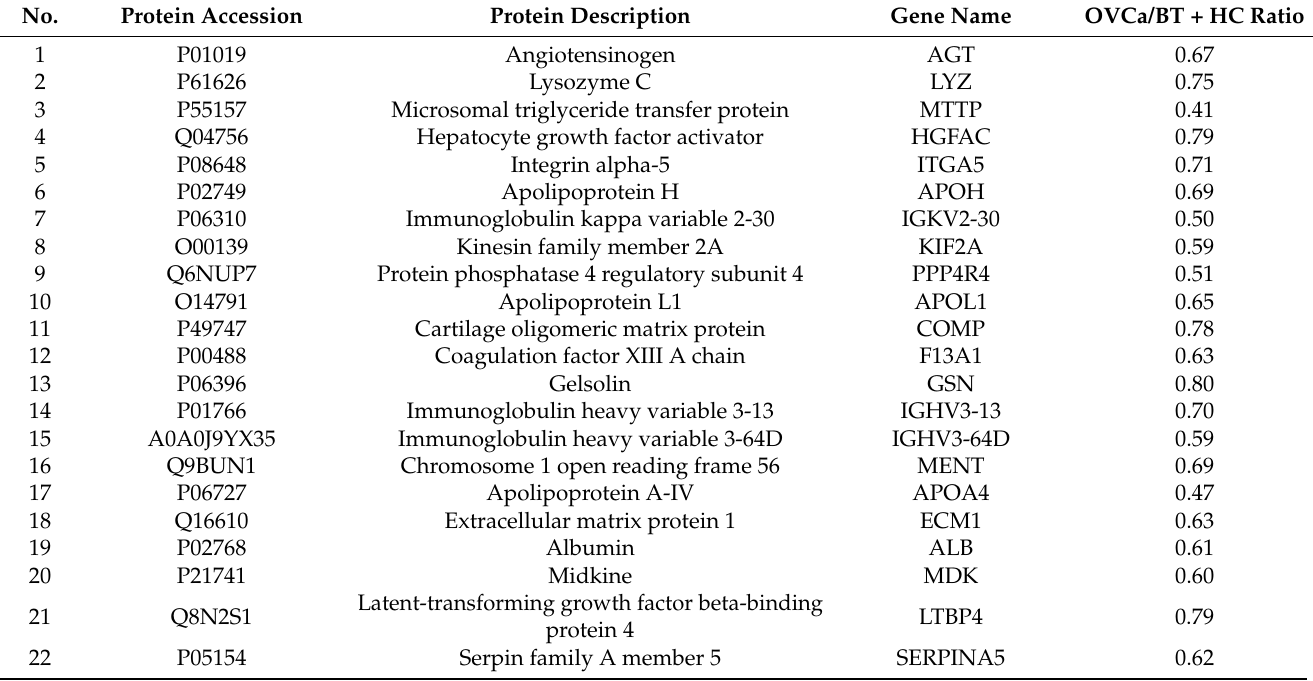
Table 2. The downregulated DEPs existed in both Ca/Cys group and Ca/HC group (<1/1.2 fold).